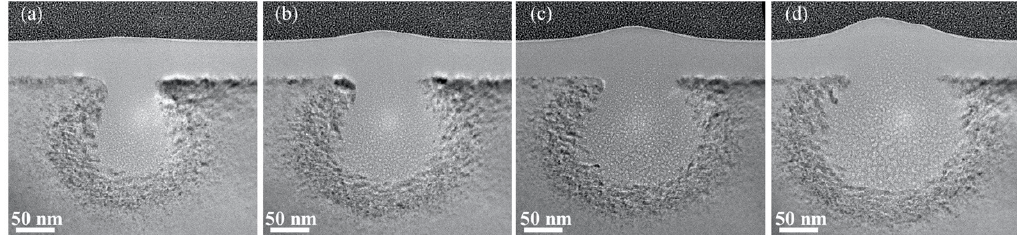
Figure 10. TEM images of cross-section samples of silicon substrate treated with He-FIB at a beam energy of 15 keV: ( a ) Ion dose of 0.02 nC / µ m; ( b ) Ion dose of 0.03 nC / µ m; ( c ) Ion dose of 0.04 nC / µ m; ( d ) Ion dose of 0.05 nC / µ m.